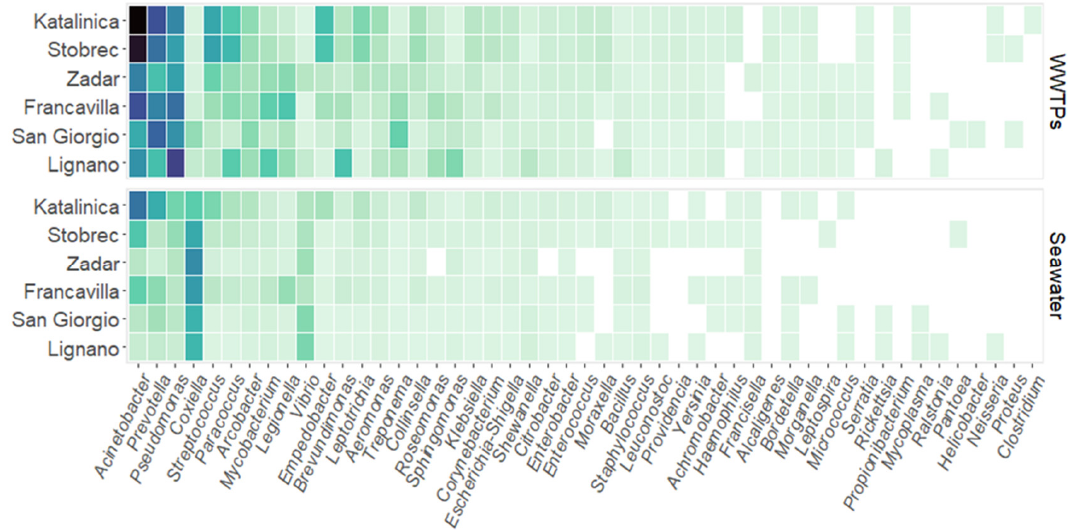
Figure 5. Potential pathogenic bacteria in treated sewage (WWTPs) and seawater samples. Out of the 60 genera investigated, Bacteriodes , Borrelia , Brucella , Burkolderia , Campylobacter , Chlamydia , Laclercia , Listeria , Orientia , and Salmonella were not found in the dataset. ASV raw counts were log(1 + x) transformed to improve visualization. Tiles represent the average count over time per site. Higher values correspond to darker shades. White tiles indicate 0 reads.